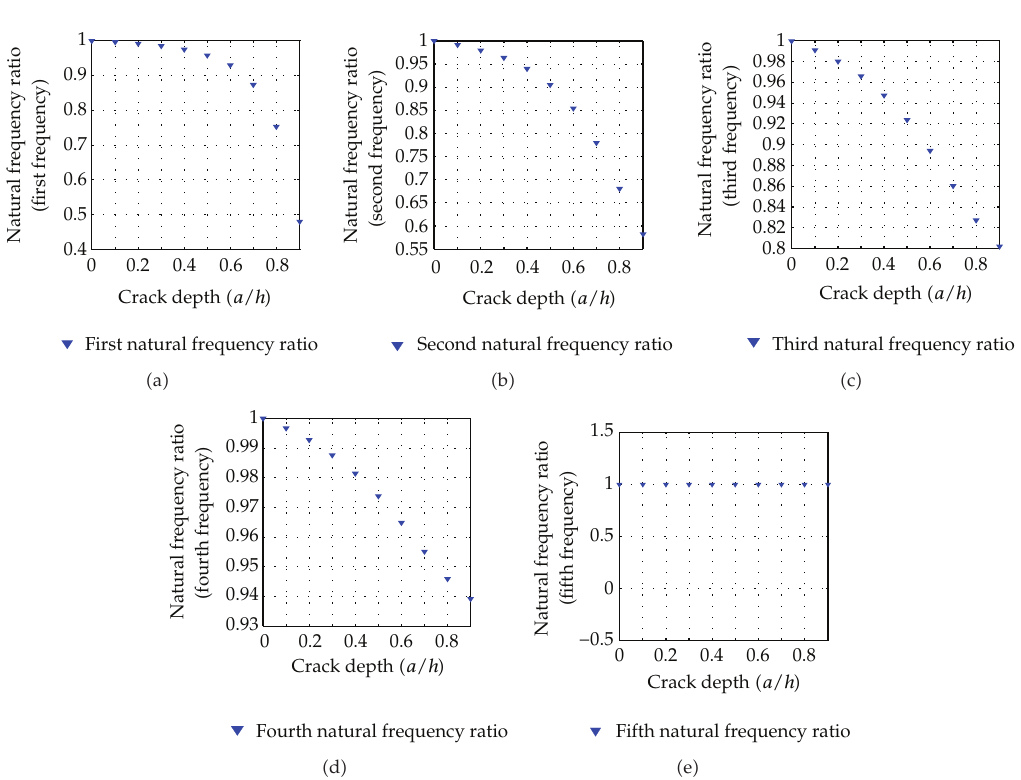
Figure 6: Variation of natural frequency ratio with the crack depth of a simply supported beam (cid:6) L 1 /L (cid:5) 0 . 8 (cid:7) : (cid:6) a (cid:7) first frequency, (cid:6) b (cid:7) second frequency, (cid:6) c (cid:7) third frequency, (cid:6) d (cid:7) fourth frequency, and (cid:6) e (cid:7) fifth